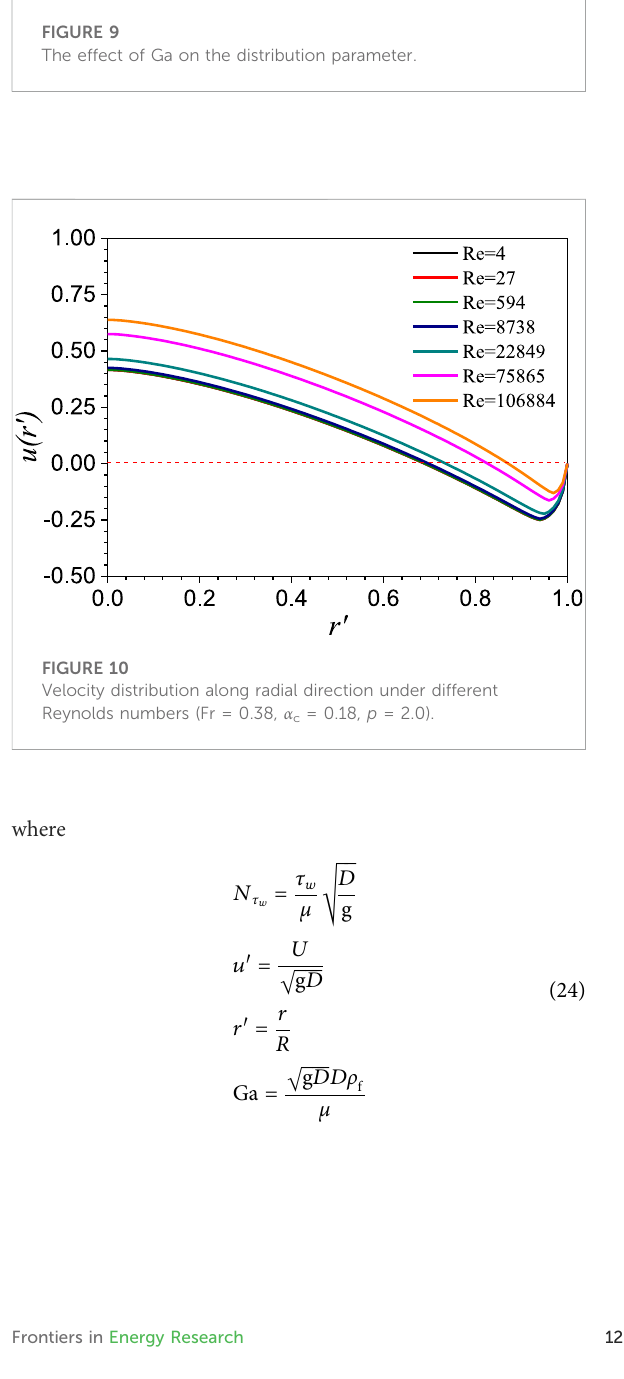
FIGURE 11 The effect of Re on the distribution parameter.